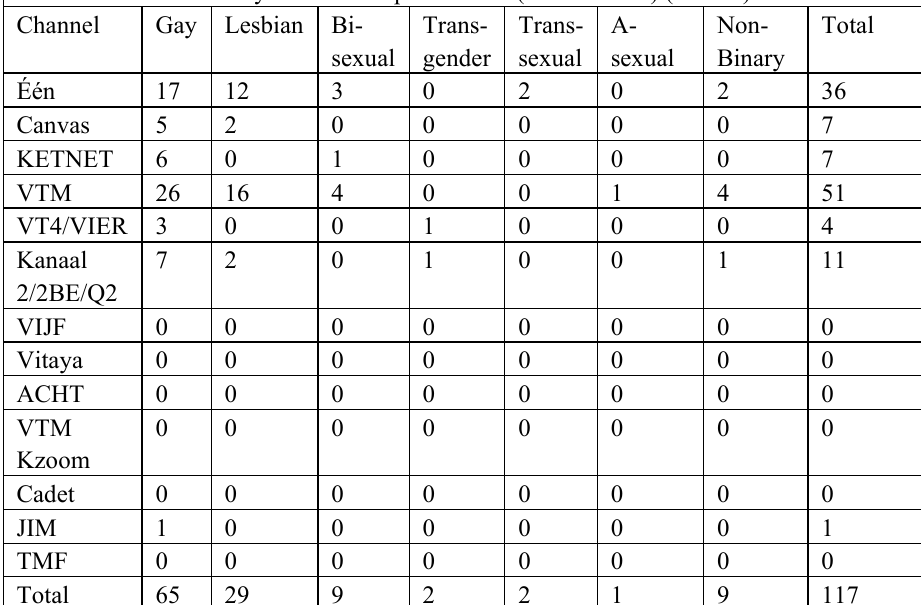
Table 5. LGBT+ identity distribution per channel (2001 – 2016) (N=117) Channel